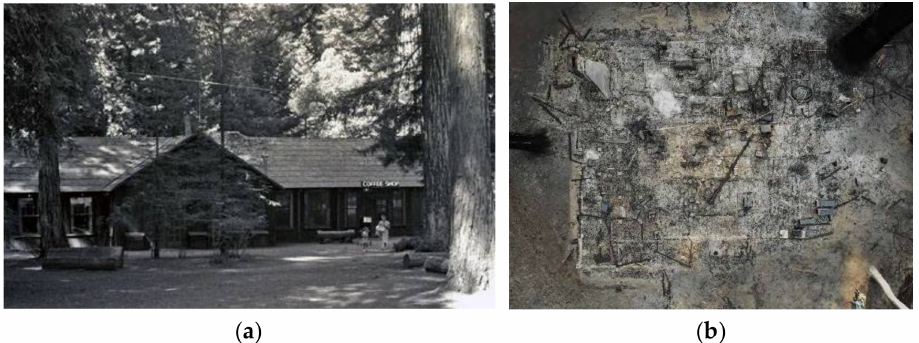
Figure 1. ( a ) The Old Lodge at Big Basin Redwoods State Park is seen in the 1950s; ( b ) aerial plan view image of the ruins of the Old Lodge after the 2020 CZU Fire. Photographs ( a ) by K. Parker and ( b ) by D. Jaffke. ( a , b ) Courtesy of California State